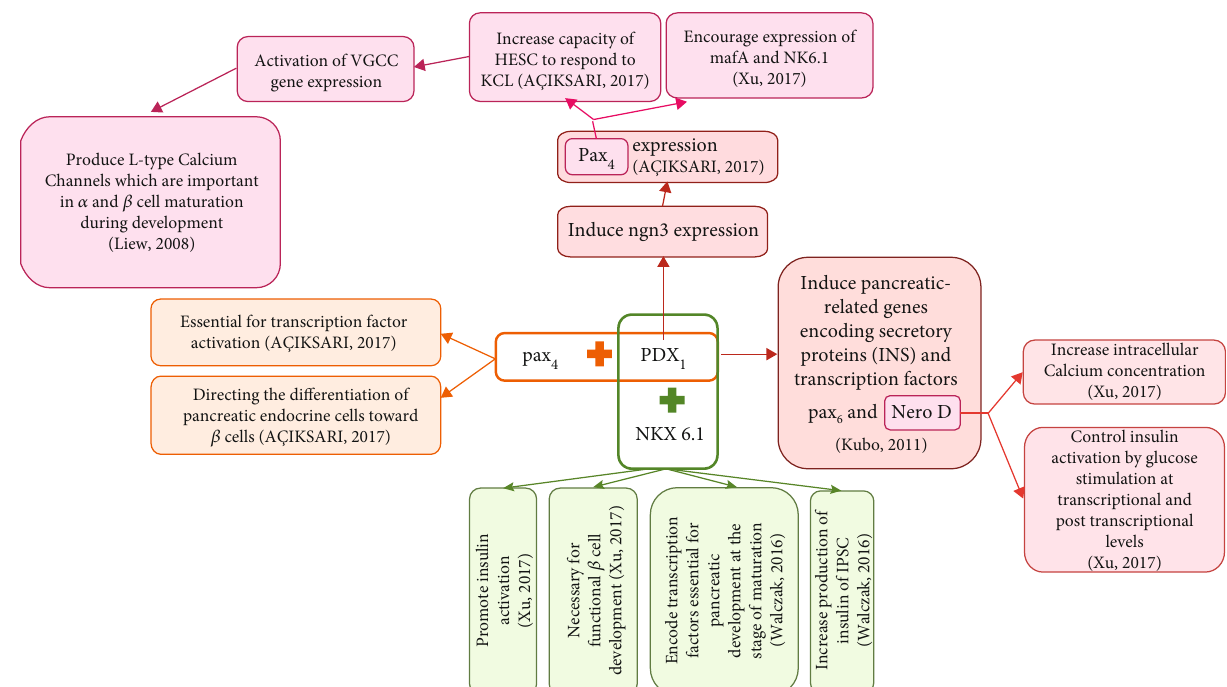
Figure 2: Summary of di ff erent pathways increasing beta cell di ff